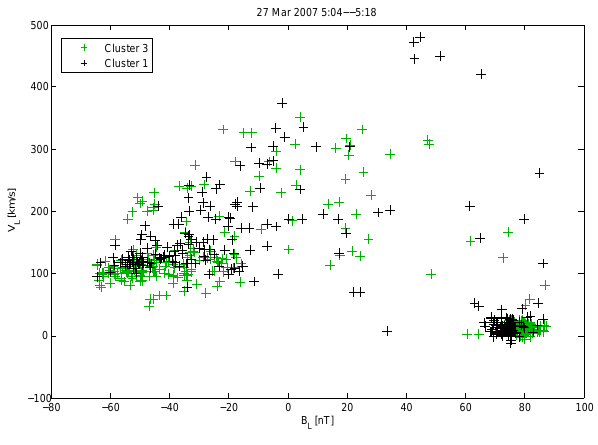
Fig. 6. Scatter plot of V L versus B L in event 1, during 05:04– 05:25UT (same interval as plotted in Fig. 3). Black crosses are data points from C1 and green crosses from C3. Both low and high flow speeds are recorded at all B L values between the magnetosphere and the magnetosheath, indicating that no stable plasma jet exists between the regions.